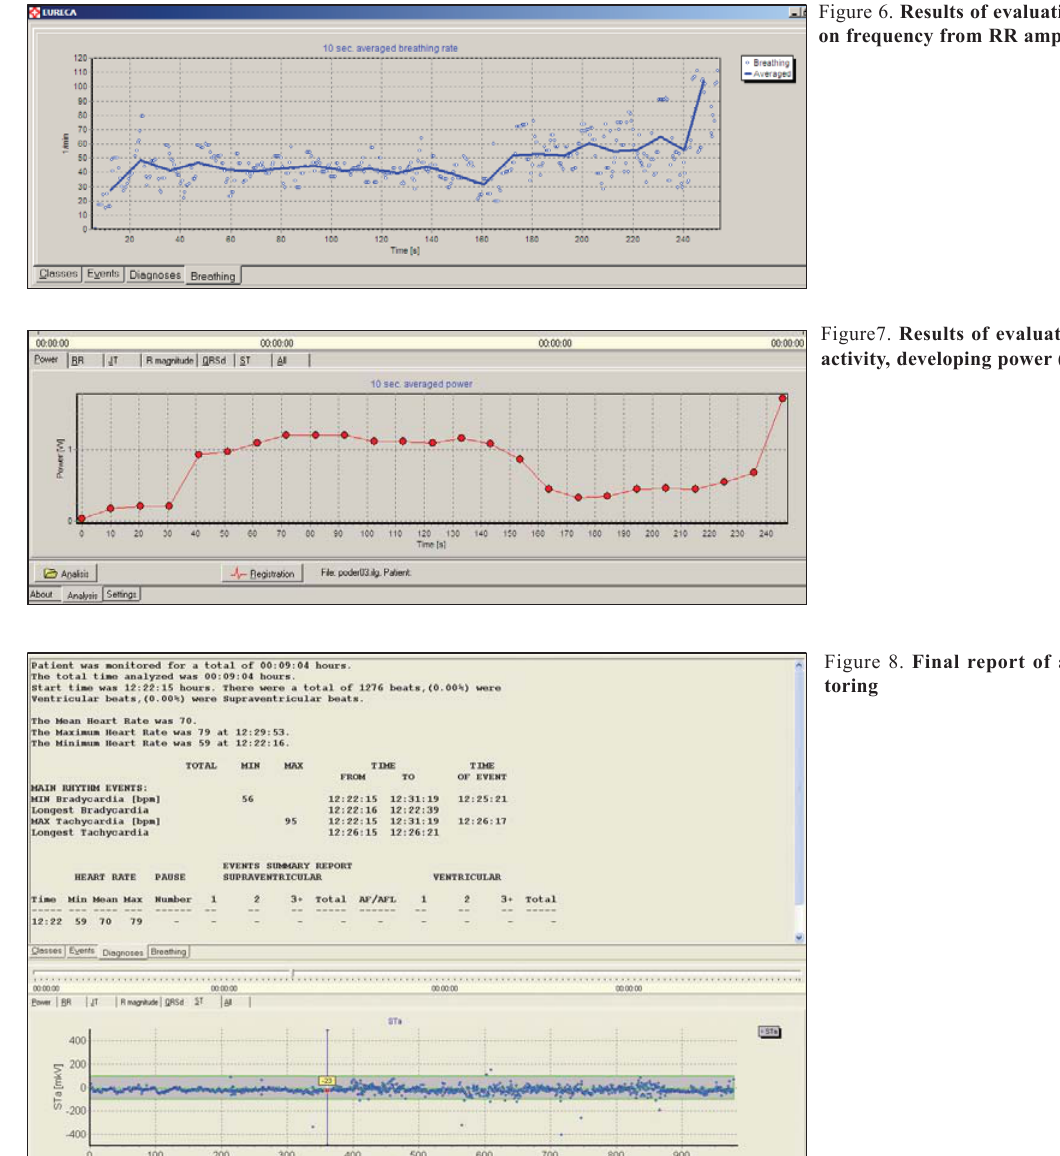
Figure 6. Results of evaluation of respirati- on frequency from RR amplitudes